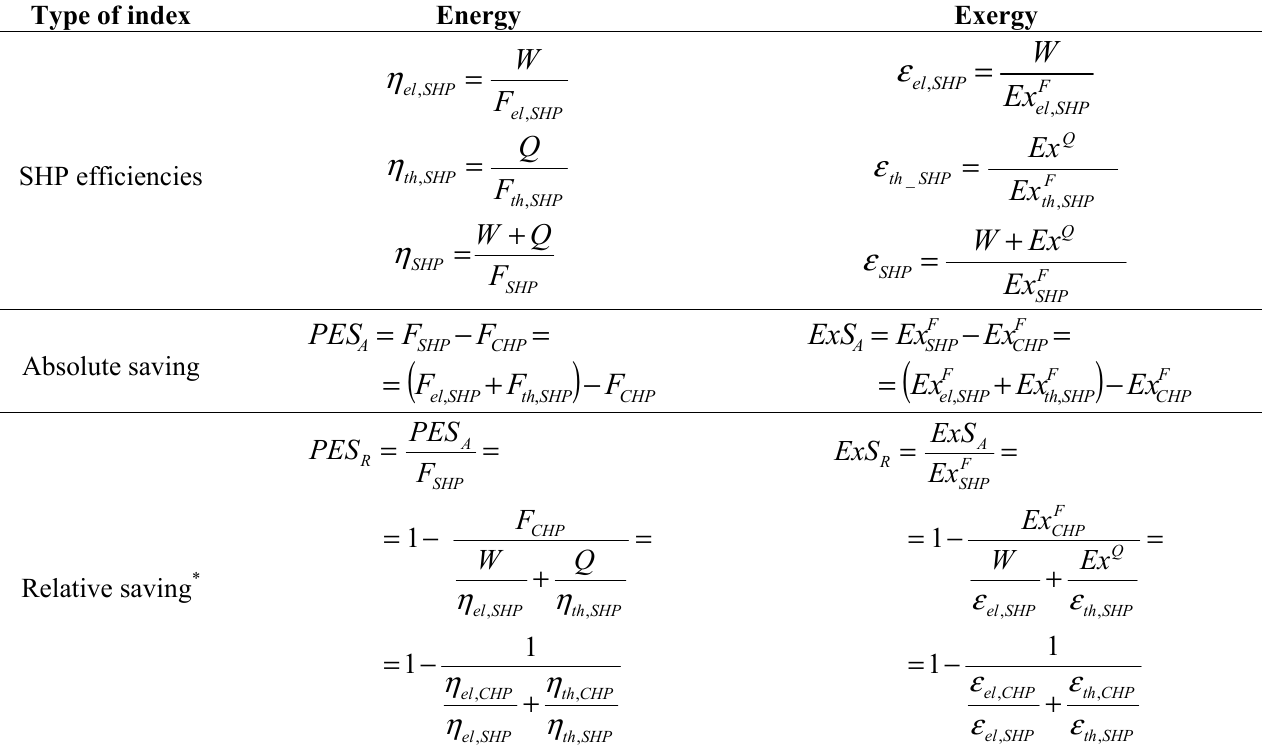
Table 1. The main equations for energy and exergy saving